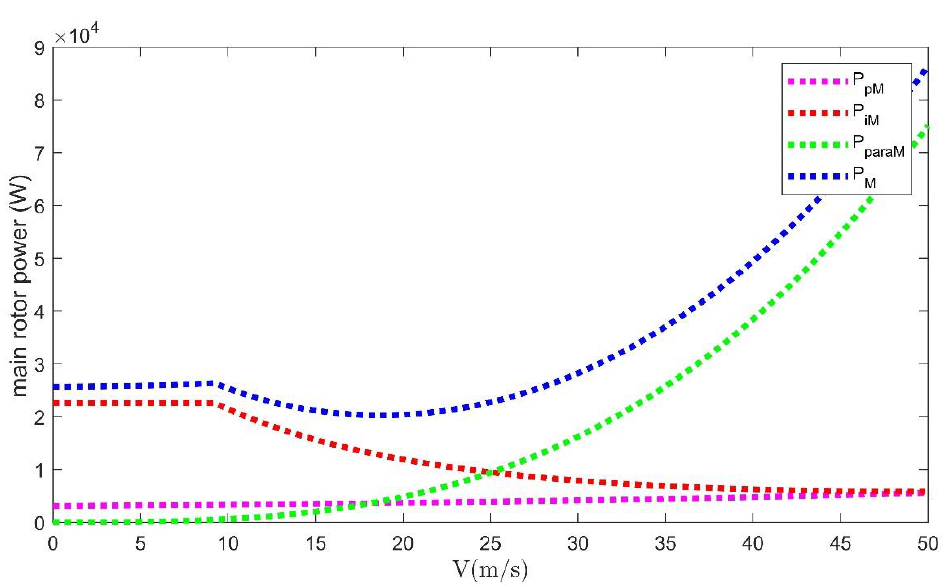
Figure 2. The main rotor power varying with the helicopter horizontal forward speed. Figure 3 shows the variation of tail rotor load T t and equivalent load T tr with the horizontal forward flight speed V .